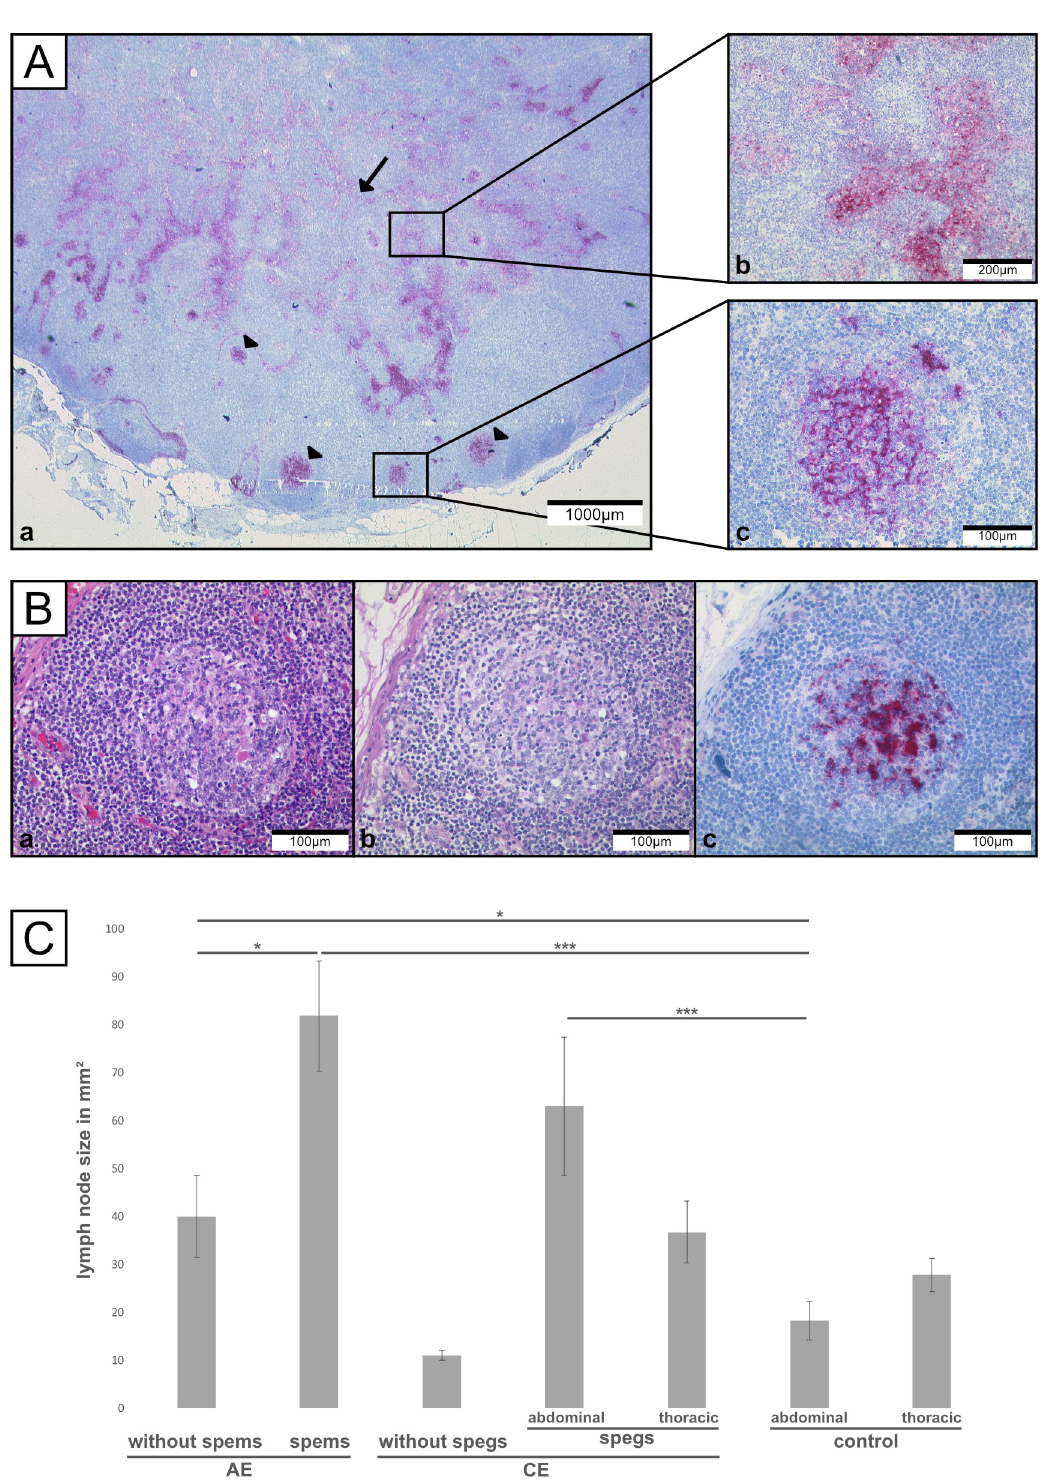
Fig 3. Regional lymph nodes of patients with alveolar or cystic echinococcosis. (Aa) Staining of mAb EmG3 of lymph node of a CE patient. Positive staining of spegs in germinal centers (arrowhead) and sinuses (arrow). (Ab) Higher magnification of sinus. (Ac) Higher magnification of germinal center. (B) High magnification of a germinal center (serial sections: a: HE staining; b: PAS staining; c: mAb EmG3-staining). (C) Results of size measurements of lymph nodes. ( � ) p < 0.05 ( �� ) p < 0.01 ( ��� ) p < 0.001.